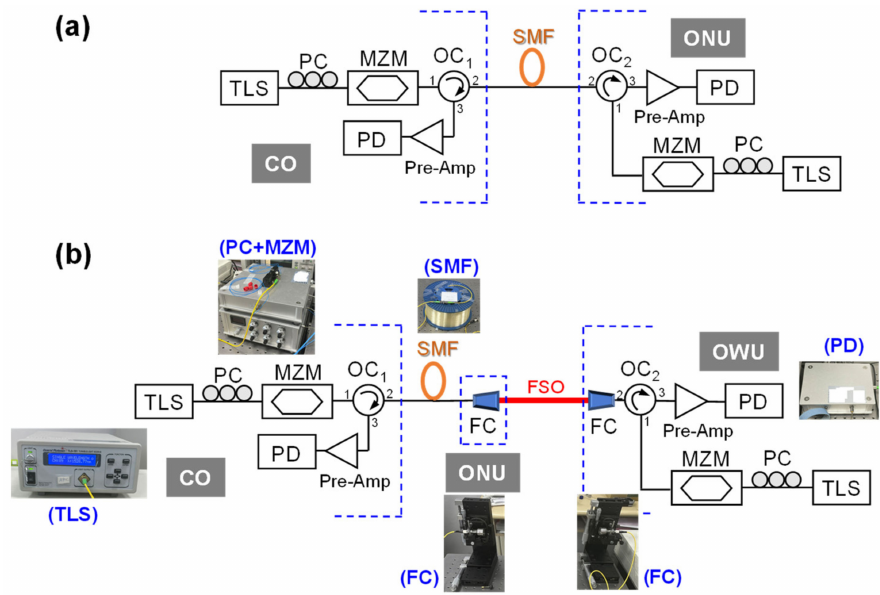
Figure 5. Experimental setup of ( a ) fiber and ( b ) FSO transmissions, respectively. The photos of insets are the corresponding active and passive